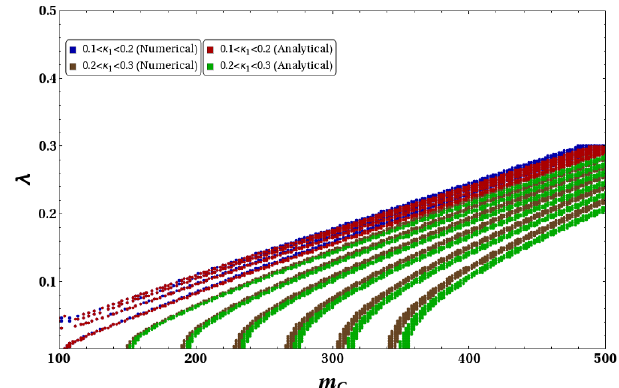
Figure 15 . Comparison between relic density allowed points for C type pNGB ((cid:10) C h 2 < 1) found using numerical solution to coupled Boltzmann equation (eq. (C.3)) and approximate analytical solutions as in eq. (4.17) in m C (GeV) - (cid:21) plane for (cid:20) : f 0 : 1 (cid:0) 0 : 3 g